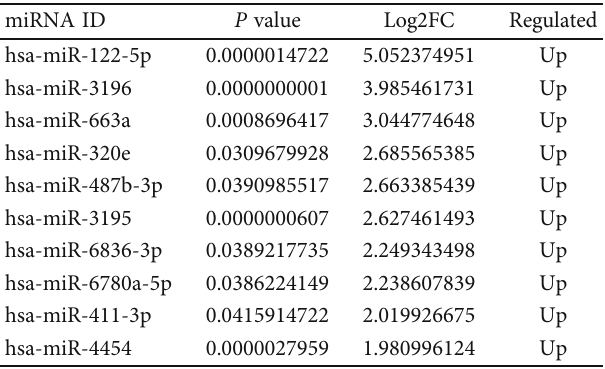
Table 1: The top ten upregulated miRNAs in the mesenchymal stem cell- (MSC-) exo vs. the MSC supernatant+GW4869 group. miRNA ID P value